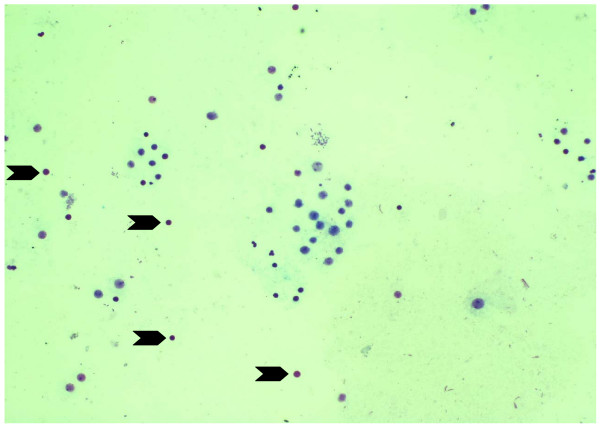
Lymphocyte proliferation in the 0.2 mg/ml borax concentration experimental subgroup. The black arrows indicated the dead lymphocytes in this subgroup. Borax effects on lymphocyte proliferation.